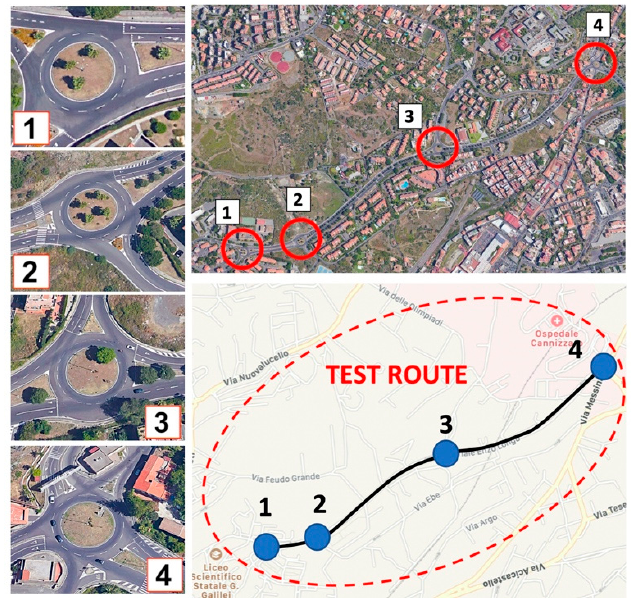
Figure 1. Details of the test route and of the roundabouts considered for the study.